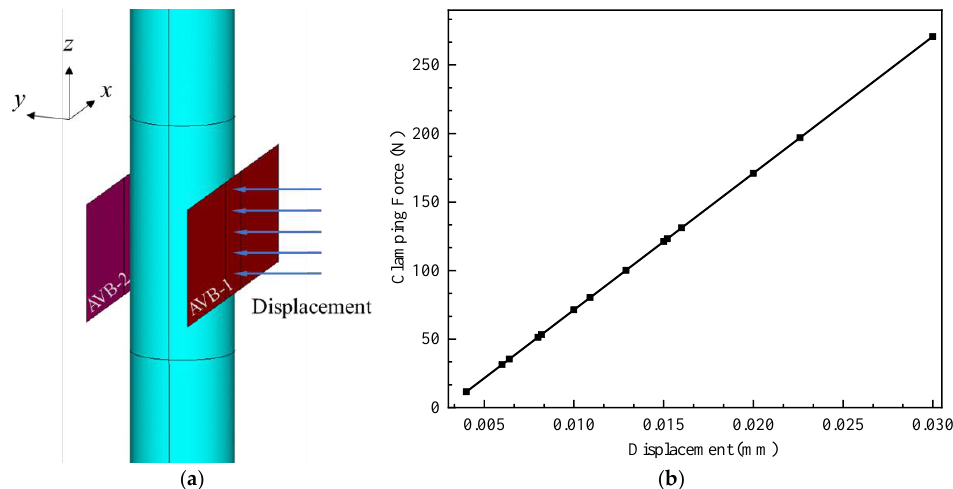
Figure 8. Static finite element analysis: ( a ) schematic diagram of static loading; ( b ) clamping force- displacement curve.